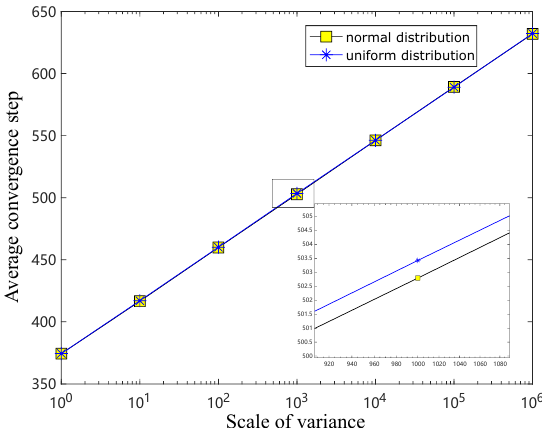
Figure 18. Convergence step vs. variance of r i ( k )